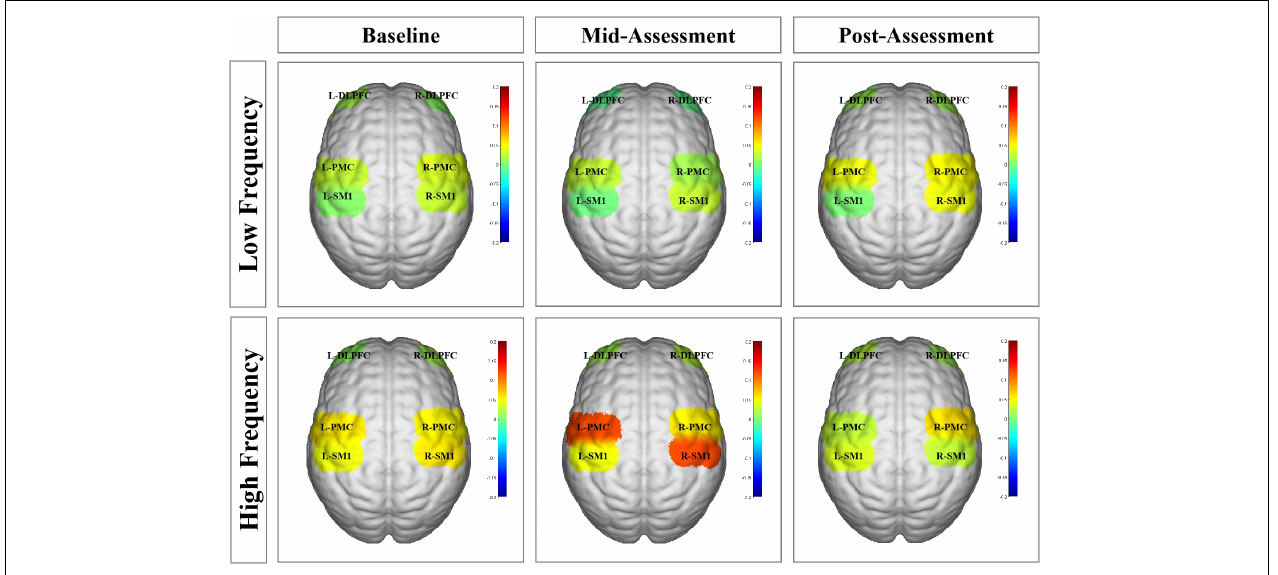
FIGURE 6 | Functional near-infrared spectroscopy (fNIRS) activation maps in different groups at three assessment time-points. The beta values are indicated by color. L-DLPFC, left dorsolateral prefrontal cortex; R-DLPFC, right dorsolateral prefrontal cortex; L-PMC, left promoter cortex; R-PMC, right promoter cortex; L-SM1, left primary sensory-motor cortex; R-SM1, right primary sensory-motor cortex; L, left; R, right. TABLE 3 | The beta values of SM1 in the Bonferroni correction for multiple comparisons between high frequency group and low frequency group. TIME Right SM1 Left SM1 Mean difference Standard error P -values Mean difference Standard error P -values Baseline 0.030 0.023 0.195 0.038 0.022 0.089 0.093 0.023 < 0.001 0.047 0.022 0.040